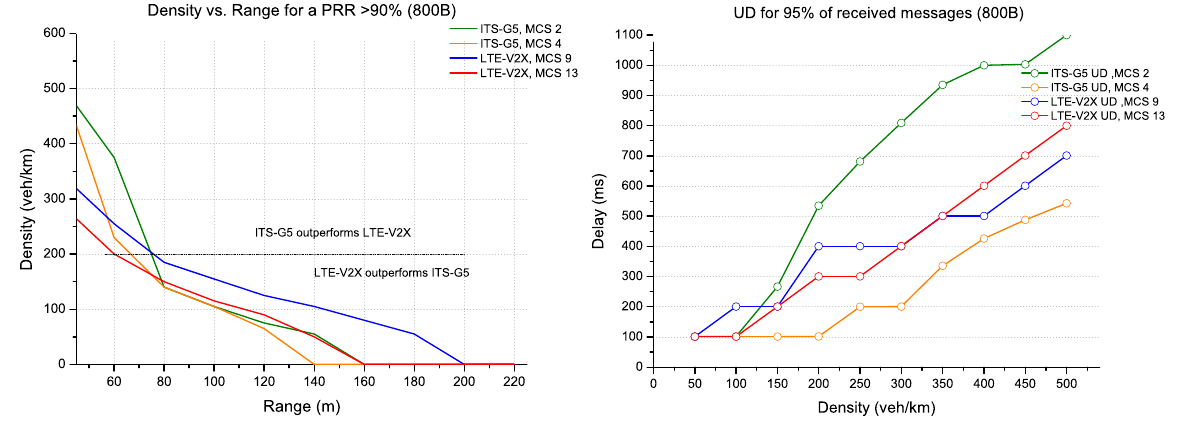
Figure 12. ITS-G5 vs. LTE-V2X comparison for packet size 800 bytes. The configuration with high MCS increases the channel capacity to support more data. Therefore, ITS-G5 with MCS 4 and LTE with MCS 13 show the best performance for data with a significant message size of 1200 bytes. Figure 13 shows that ITS-G5 overcomes LTE-V2X for high densities (more than 200/250 veh/km) against an update delay favouring LTE-V2X and vice versa for low densities.